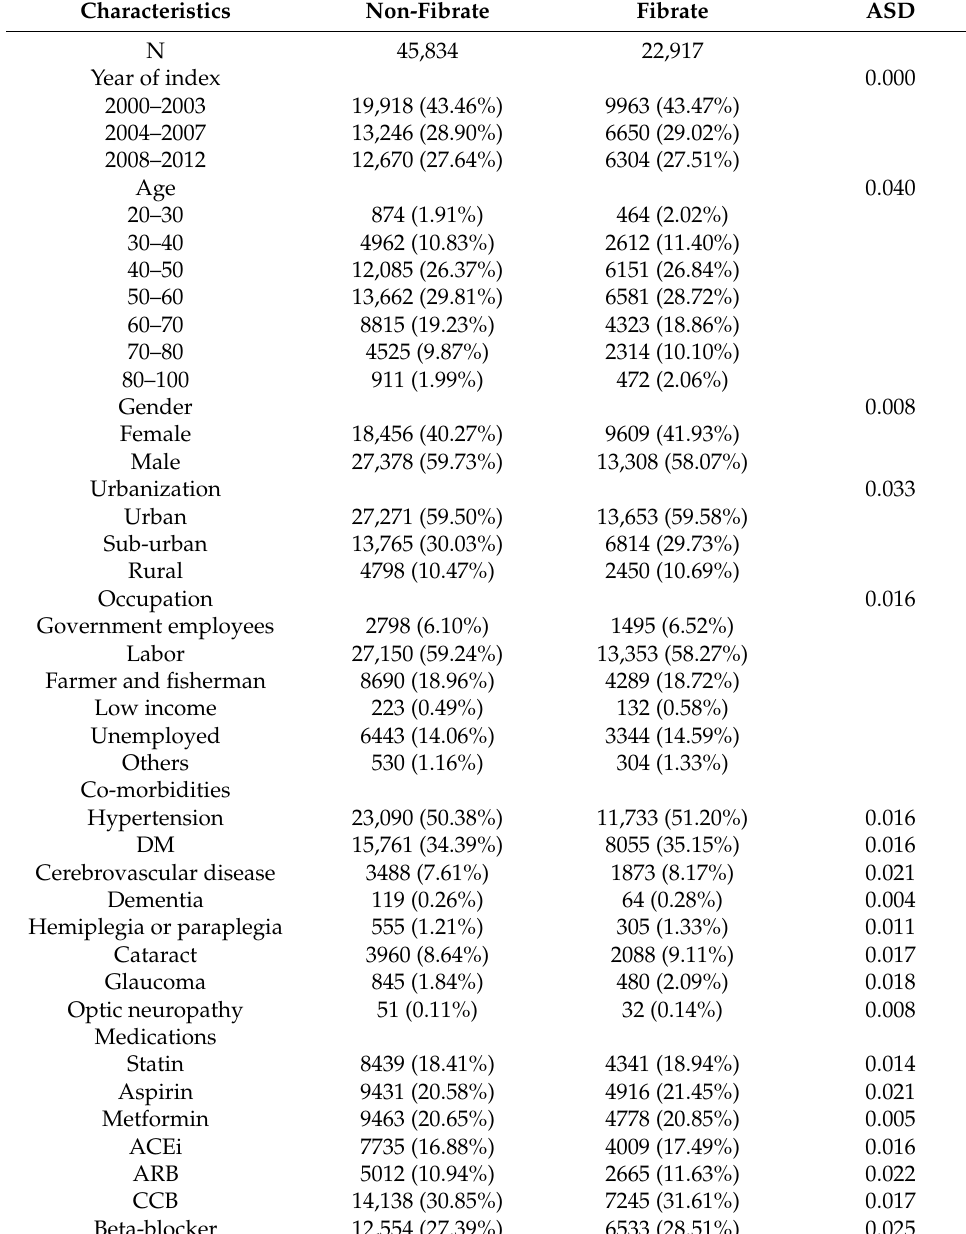
Table 2. Characteristics among fibrate and non-fibrate group after propensity score